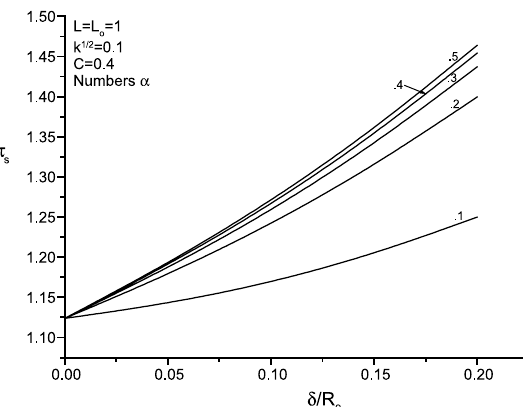
Fig. 14. Shear stress at stenosis throat, τ s versus stenosis height, δ/ R α . o for different